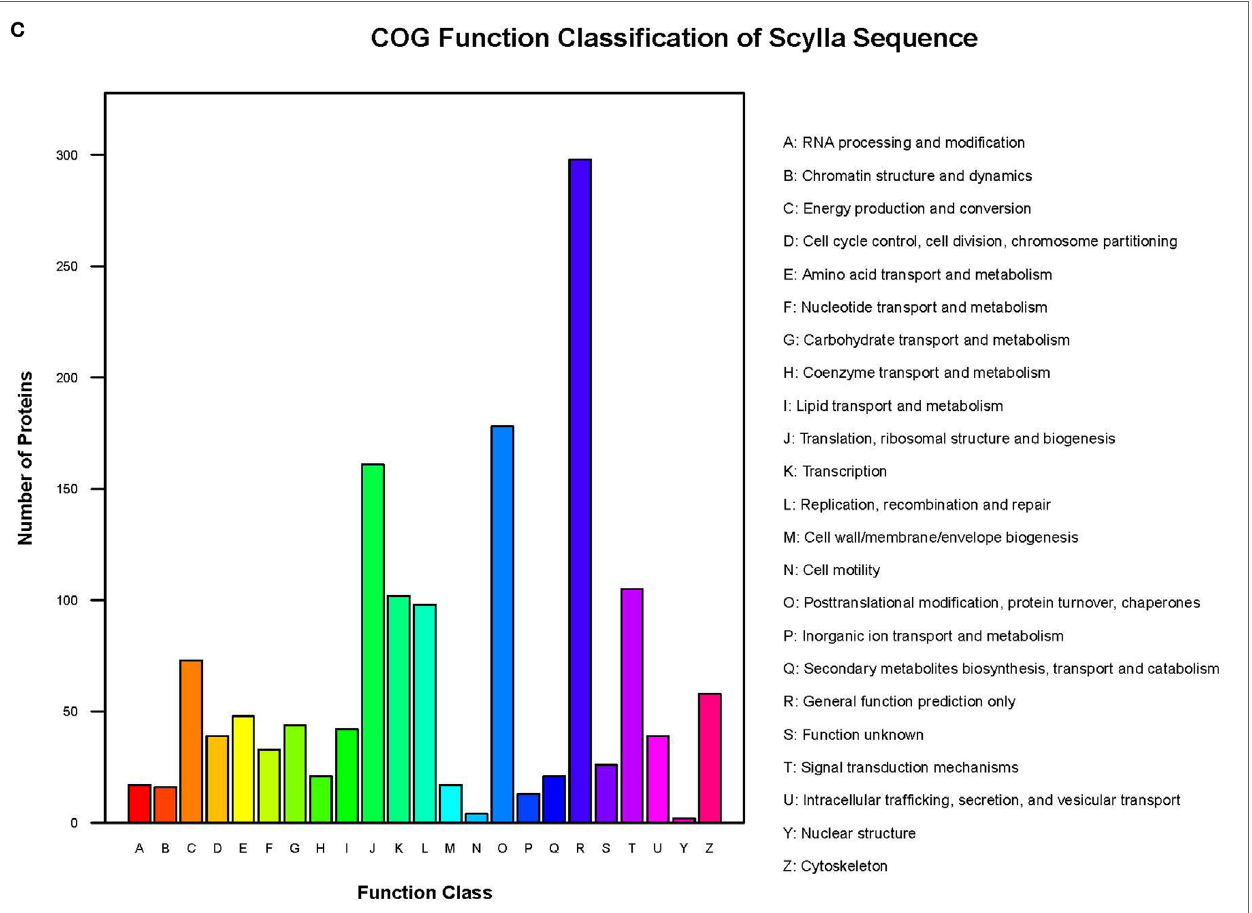
FigUre 1 | The basic information and statistics for the isobaric tags for relative and absolute quantitation analysis of Scylla paramamosain hemocyte proteome . (a) Coverage of proteins by the identified peptides. (B) Distribution of identified proteins among different molecular weights (in kilodaltons). (c) Distribution of proteins containing different number of identified